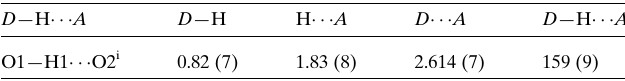
Table 1 Hydrogen-bond geometry (A˚ , (cid:3) ).